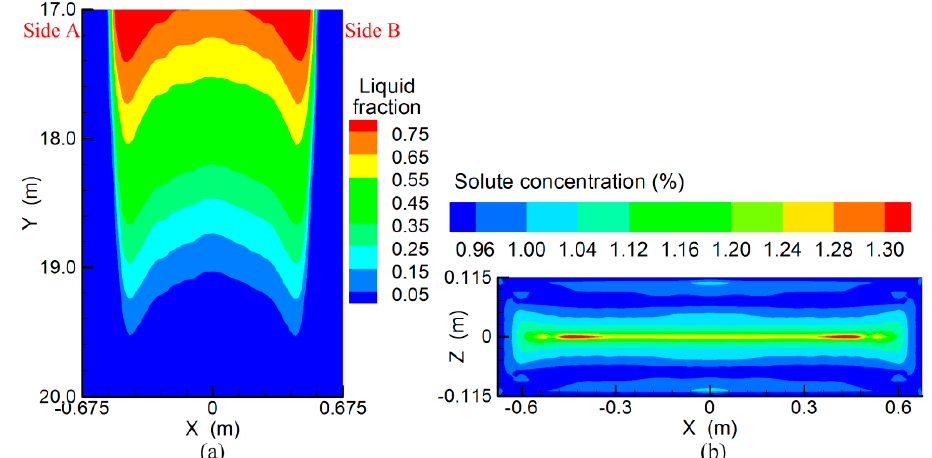
Figure 6. Liquid fraction in the strand longitudinal section ( a ) and solute distribution in the cross section ( b ). section ( b